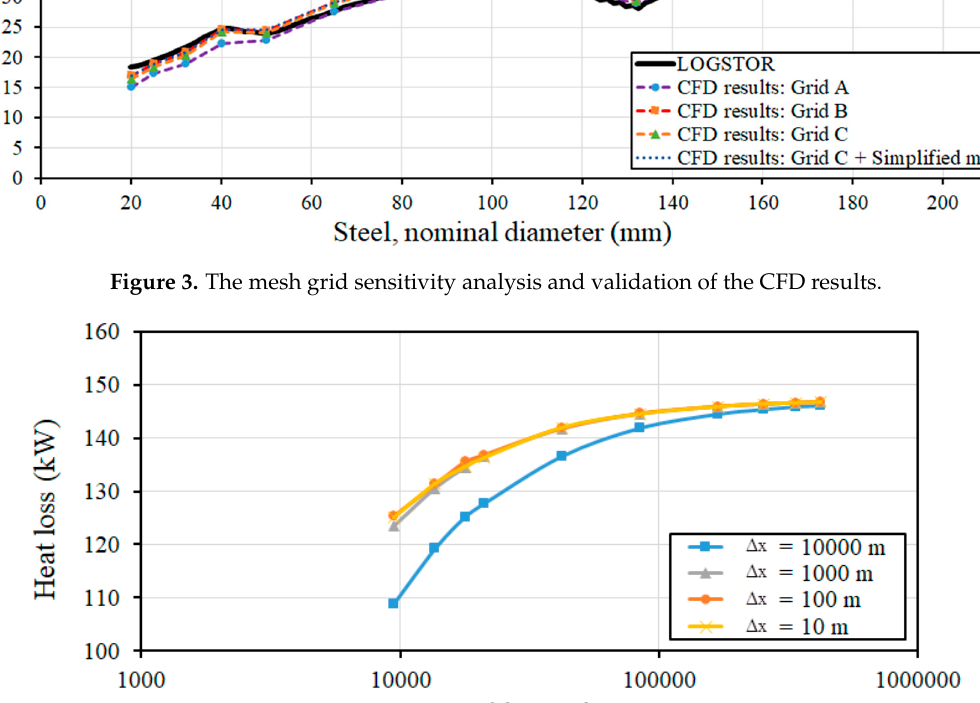
c Figure 5. Contours of radial temperature distribution for the pipes through the insulations. ( a ) Low- Temperature DH systems; ( b ) Ultralow-Temperature DH system; ( c ) Variable-Temperature DH system.